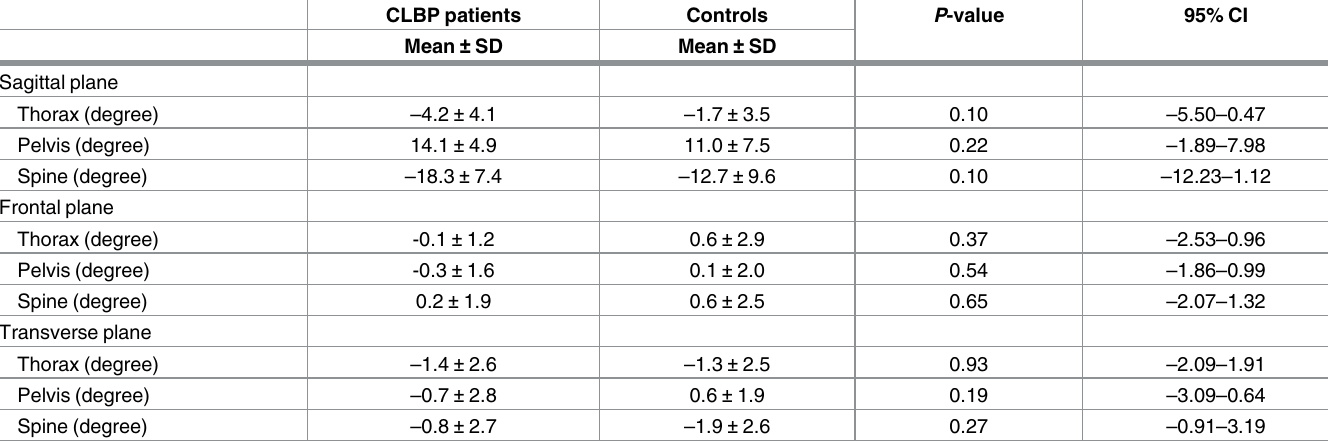
Table 2. The angles of the thorax, pelvis, and spine in a static standing